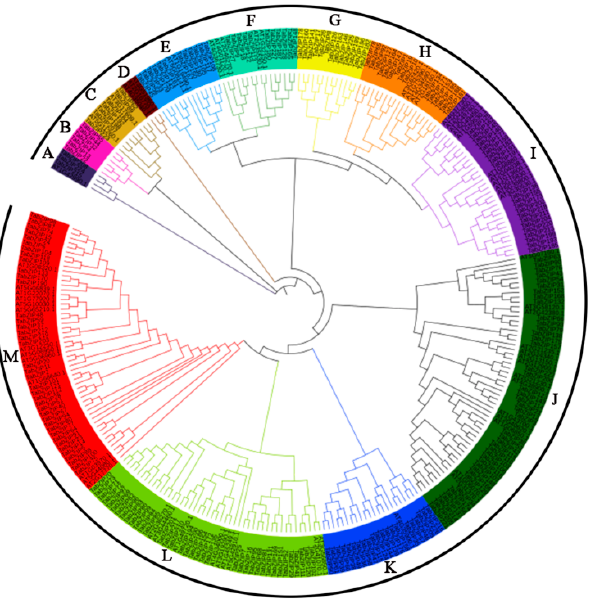
Figure 1. The phylogenetic tree of bZIP genes in wheat and A. thaliana . Different colors indicate different subfamilies (A–M).